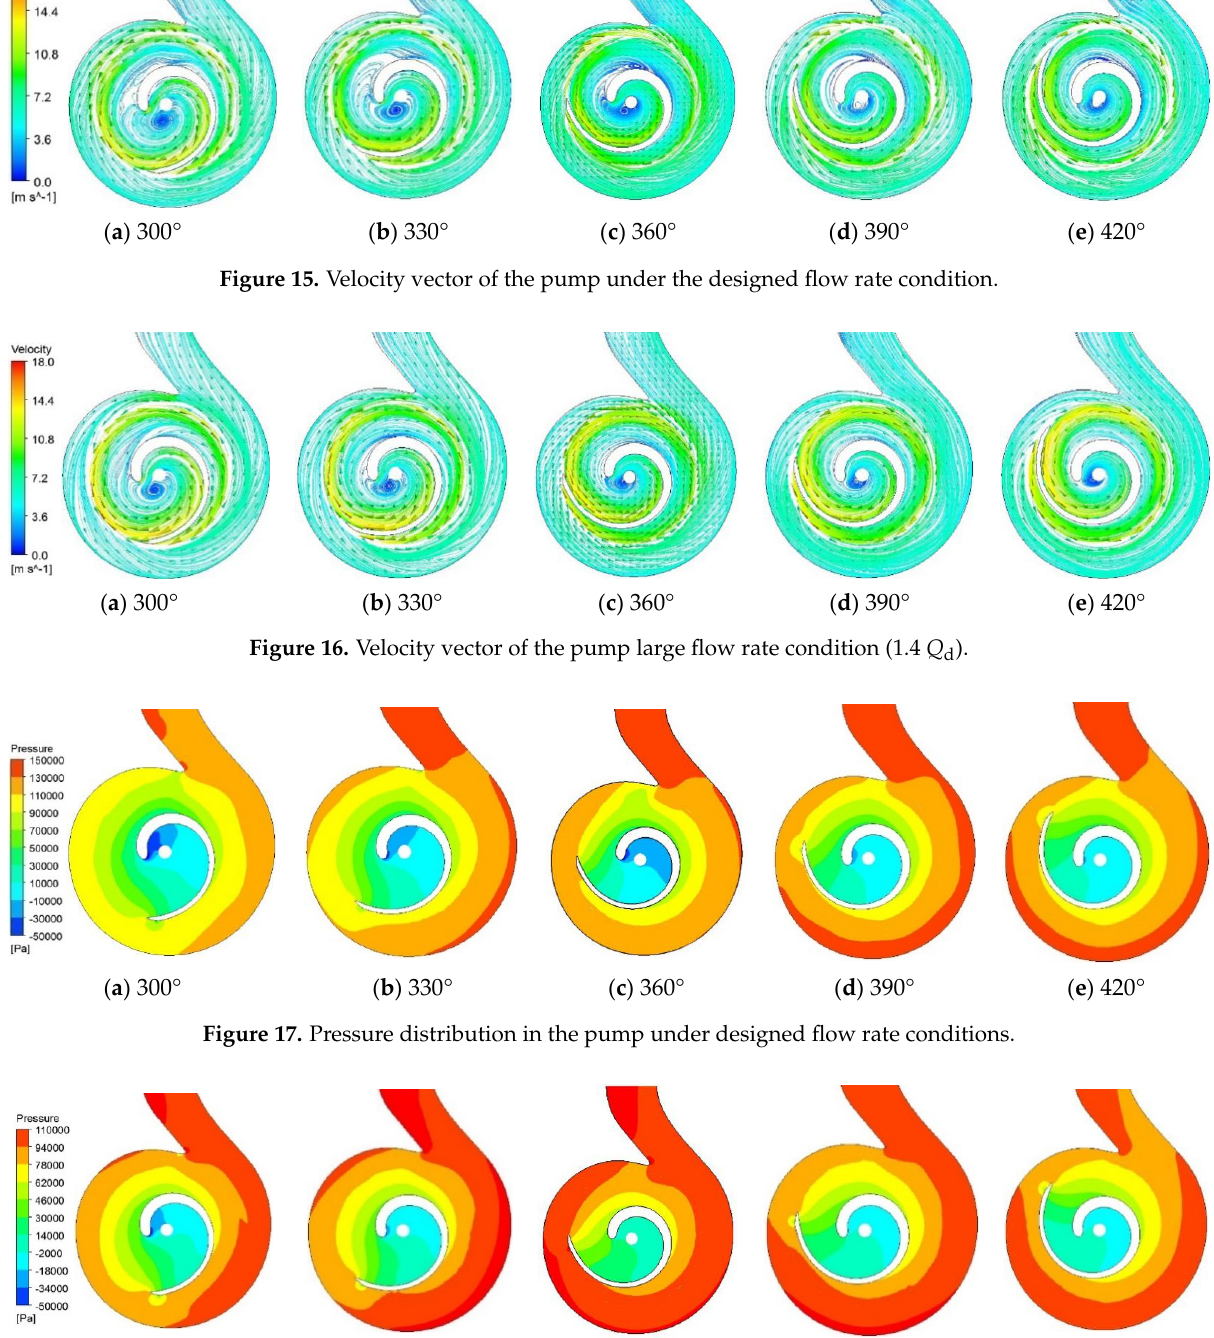
Figure 19. Pressure distribution at the impeller outlet under designed flow rate condition.